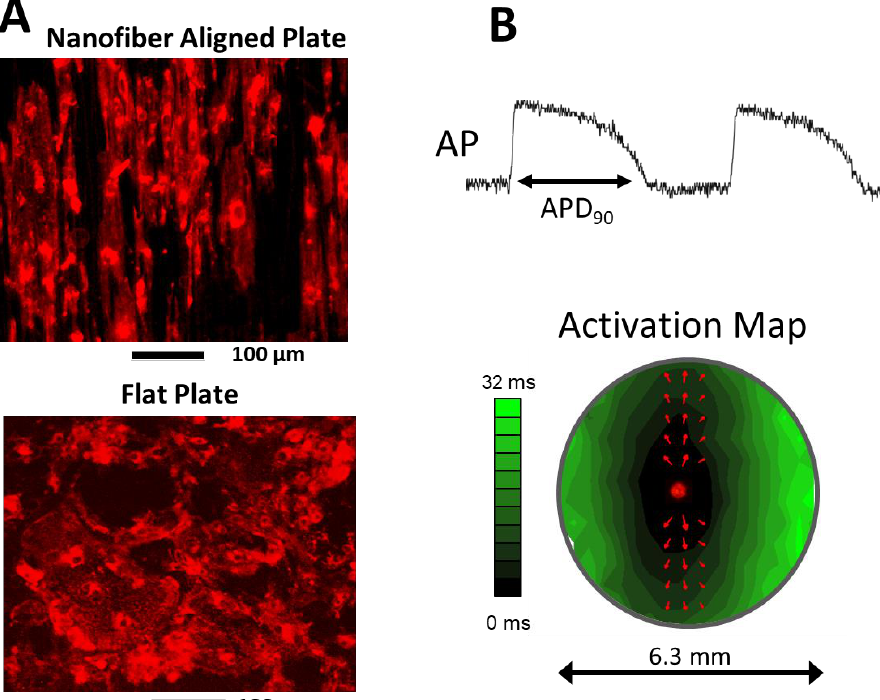
Figure 1. Cardiac myocytes derived from iPSCs and iCells were plated on 3D nanofiber-aligned 96-well plates to obtain a more mature structure ( A , top ) compared to a flat plate ( A , bottom ). In these examples, cells stained with Di-4-ANEPPS, were plated at a low density so that cell boundaries could be observed. Representative example of an action potential recorded from a single site within a well is shown with the APD 90 measurement superimposed ( B , top ). Activation times determined at each site within a well were used to construct an activation map ( B , bottom ) from which local conduction velocity vectors in the longitudinal direction were averaged for each recording (red ar- rows). 3. Results Critical to our aims, we differentiated cardiac myocytes and MSCs from human wildtype (CNTL) iPSCs and human iPSCs with the S358L mutation. Firstly, we sequenced the genomic DNA of undifferentiated human iPSCs and differentiated myocytes and con- firmed the S358L mutation in the patient S358L iPSCs and S358L IPSCs-derived cardio- myocytes (S358L CM, Figure 2A). Secondly, we observed no significant difference in TMEM43 mRNA expression between CNTL and S358L iPSCs, MSCs, and CM (Figure 2B). Finally, high TMEM43 message expressed in all MSCs was consistent with TMEM43 pro- tein expression in all MSCs (Figure 2C). These results validated the TMEM43 S358L mu- tation in patient iPSCs and their derivatives, and they showed that MSCs highly express TMEM43 at the mRNA and protein levels.